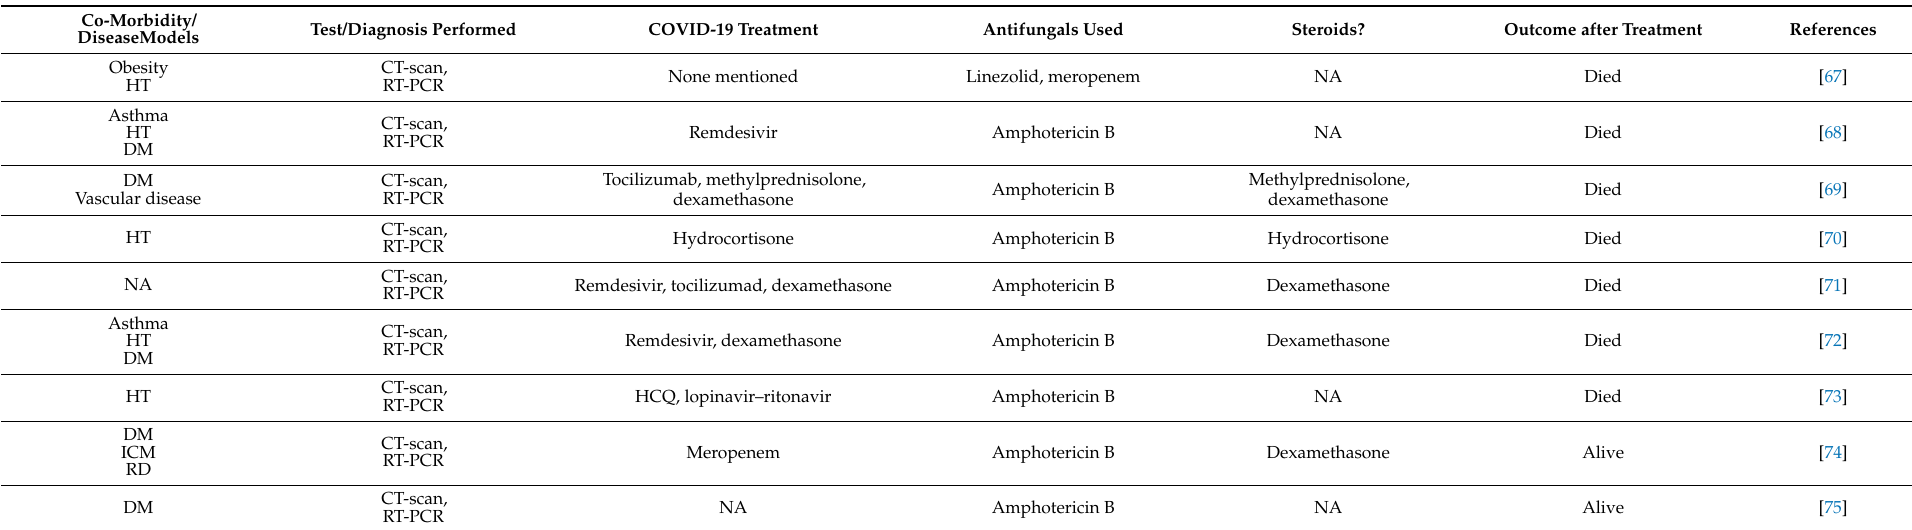
Table 4. Clinical characteristics of COVID-19 patients reported with